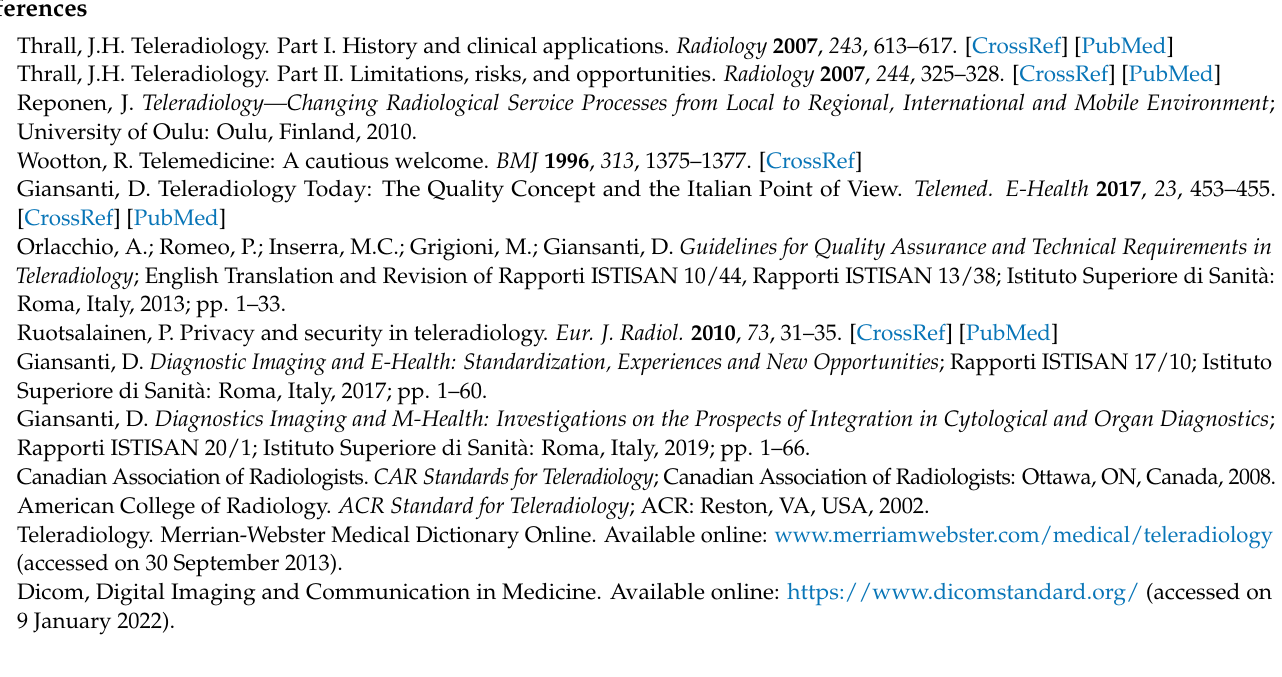
Figure A2. An example of the survey (second print screen).